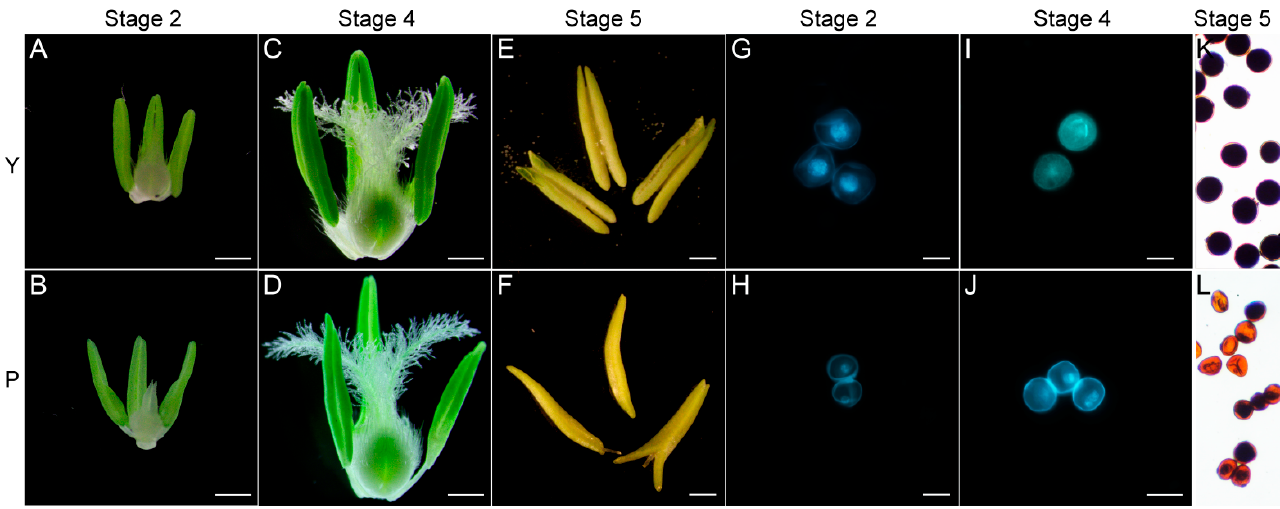
Figure 2. Phenotype of anthers and microspores in different stages in male sterile (P) and its maintainer (Y). Stage 2 ( A , B , G , H ): Early uninucleate stage; Stage 4 ( C , D , I , J ): Binucleate stage; and Stage 5 ( E , F , K , L ): Trinucleate stage. Bars: 500 μ m in ( A – F ); 50 μ m in ( G – J ).